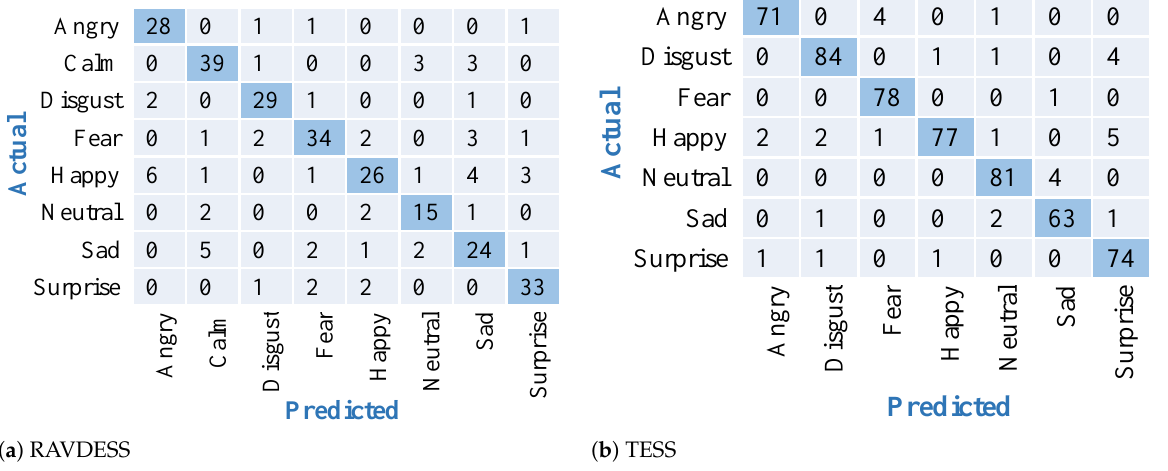
Figure 6. Confusion matrices for feature extraction and modeling using Resnet-18 over 2 datasets. Diagonal elements with dark blue color show accurately predicted classes. Table 2. Comparative analysis of RAVDESS and TESS. SERIAL